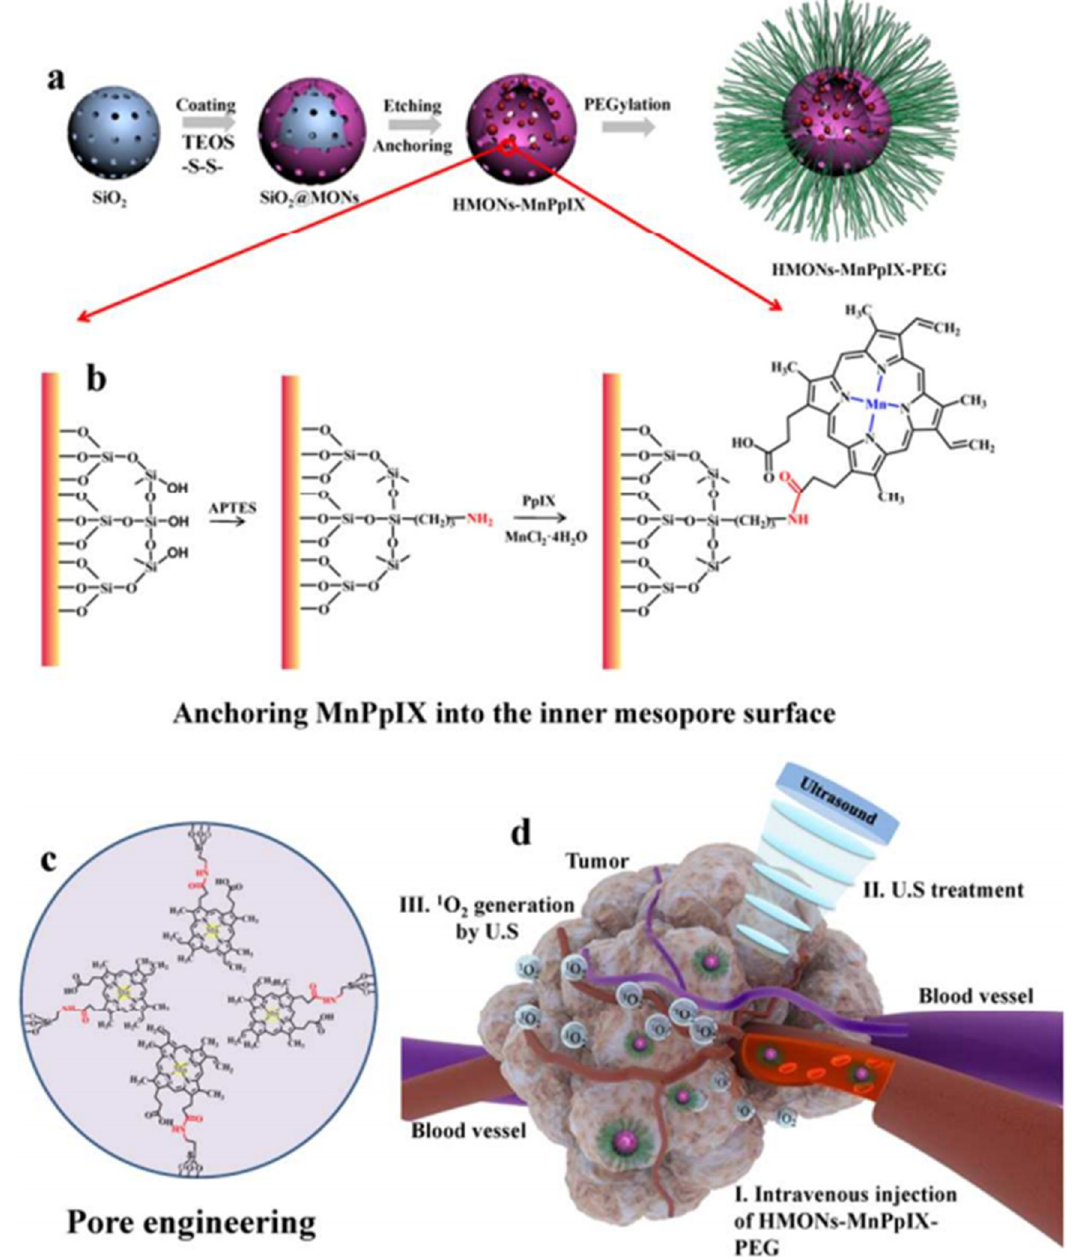
Figure 3: Schematic illustration of the synthesis of HMONs - MnPpIX - PEG ( a – c ) and the mechanism of HMONs - MnPpIX - PEG binding to SDT ( d ) . Reproduced with permission [ 26 ] . Copyright 2016, American Chemical